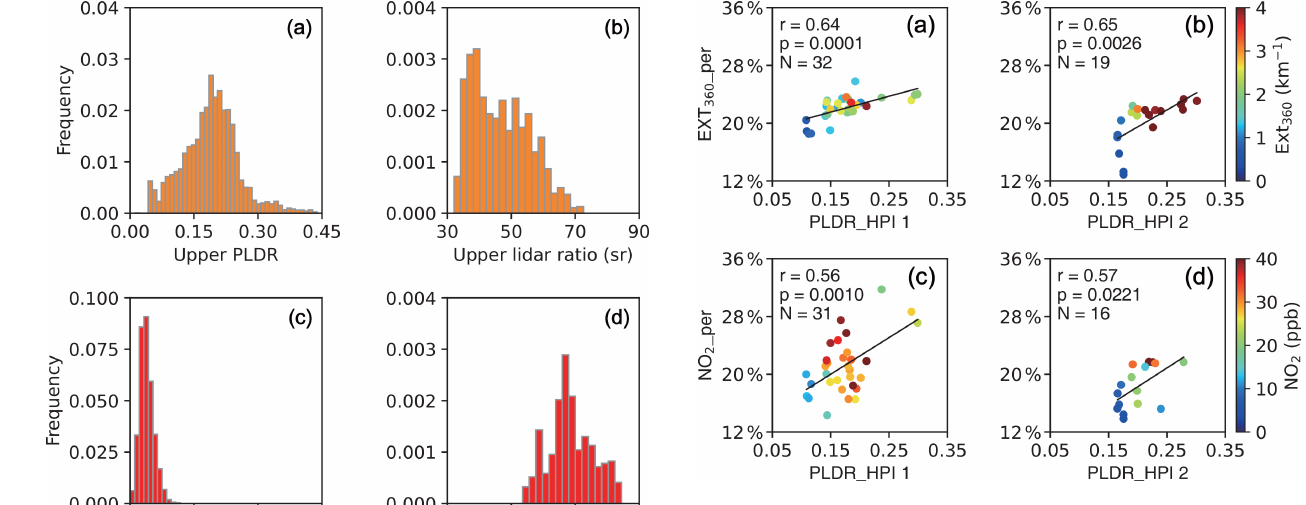
Figure 4. Average PLDR trend in the upper lidar layer during the two HPIs and its impact on lower level air pollution. Scatterplots showing relationships between the average PLDR and the average percentages of bottom (a) EXT 360 during the HPI 1, (b) EXT 360 during the HPI 2, (c) NO 2 VMRs during the HPI 1, and (d) NO 2 VMRs during the HPI 2. The colors in (a) and (b) represent the surface EXT 360 , and the colors in (c) and (d) represent the sur- face NO 2 concentration. The spatially averaged range of PLDR is 950–1050m. The hourly averages of PLDR, percentage of bottom EXT 360 , and percentage of bottom NO 2 VMR are used due to the different temporal resolution between RL and MAX-DOAS. The correlation coefficients are shown in the top left; N = number of samples. The analysis period was from 08:00 to 16:00LT because MAX-DOAS can only be performed during the